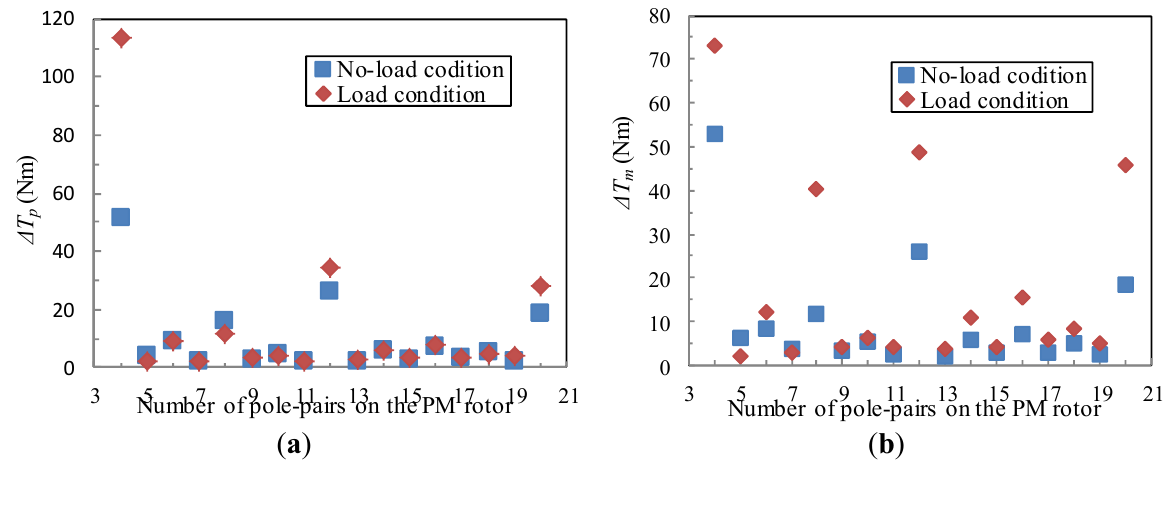
( ,2 ) LCM p p m p with the number of pole pairs of 2 p p